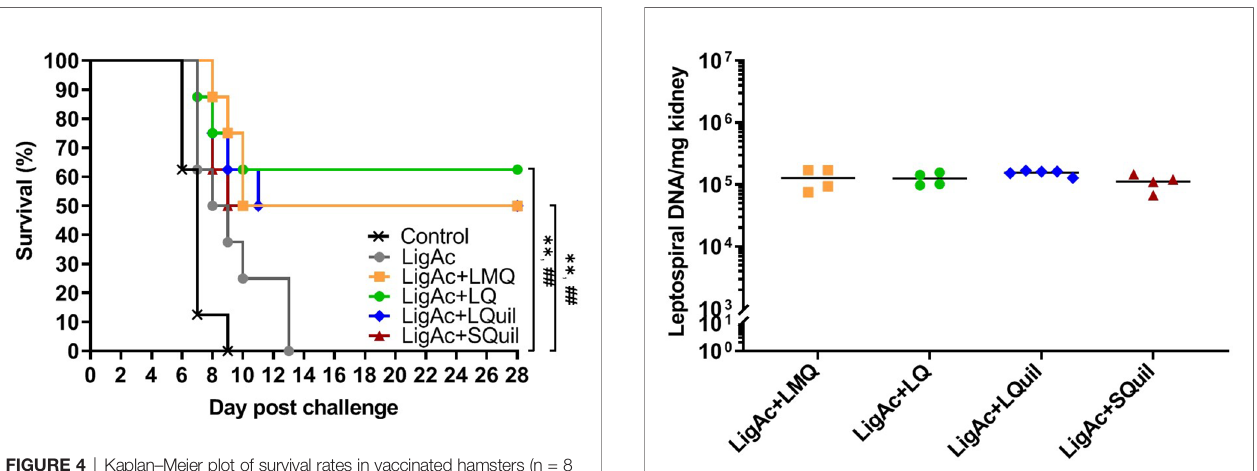
FIGURE 5 | Leptospiral burden in the kidneys of surviving hamsters after challenge. The leptospiral genome was detected by qPCR. The cycle threshold of each sample was compared with leptospiral DNA standard curve to calculate bacterial load, which is expressed as bacterial DNA per milligram of tissue. Mann – Whitney U test was used to compare bacterial numbers among vaccinated groups.